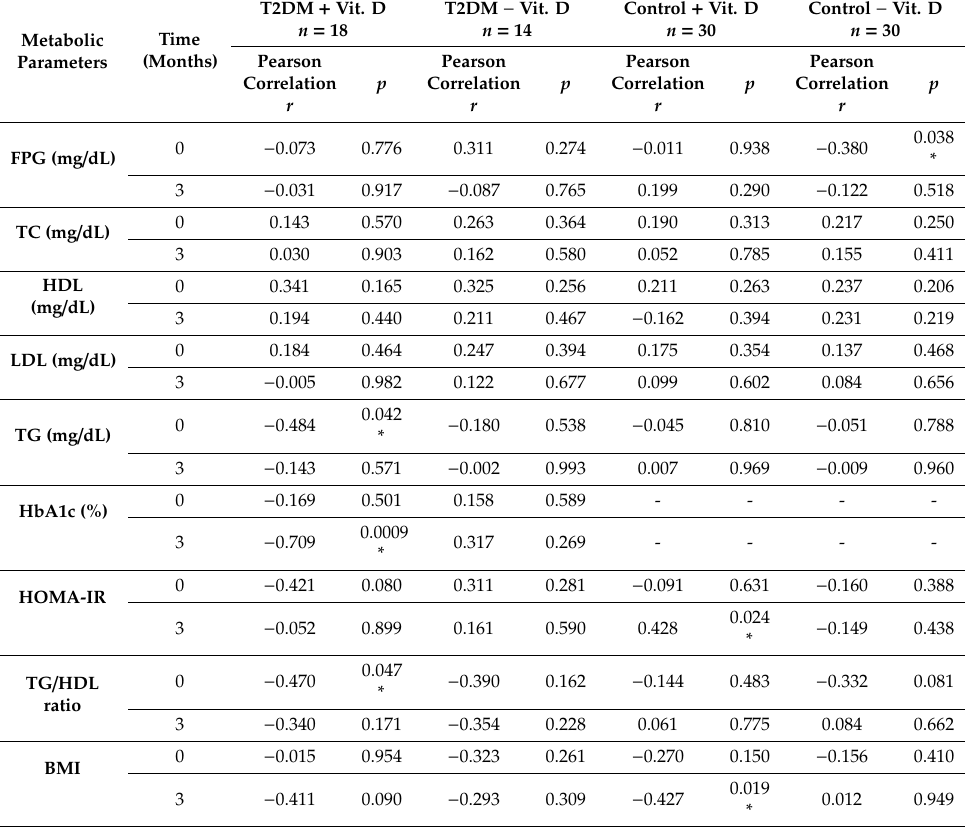
Table 7. The correlation between vitamin D and FPG, HbA1C, TC, LDL, HDL, TG in patients with T2DM (T2DM + Vit. D, n = 18; T2DM – Vit D, n = 14) and patients without T2DM (Control + Vit.